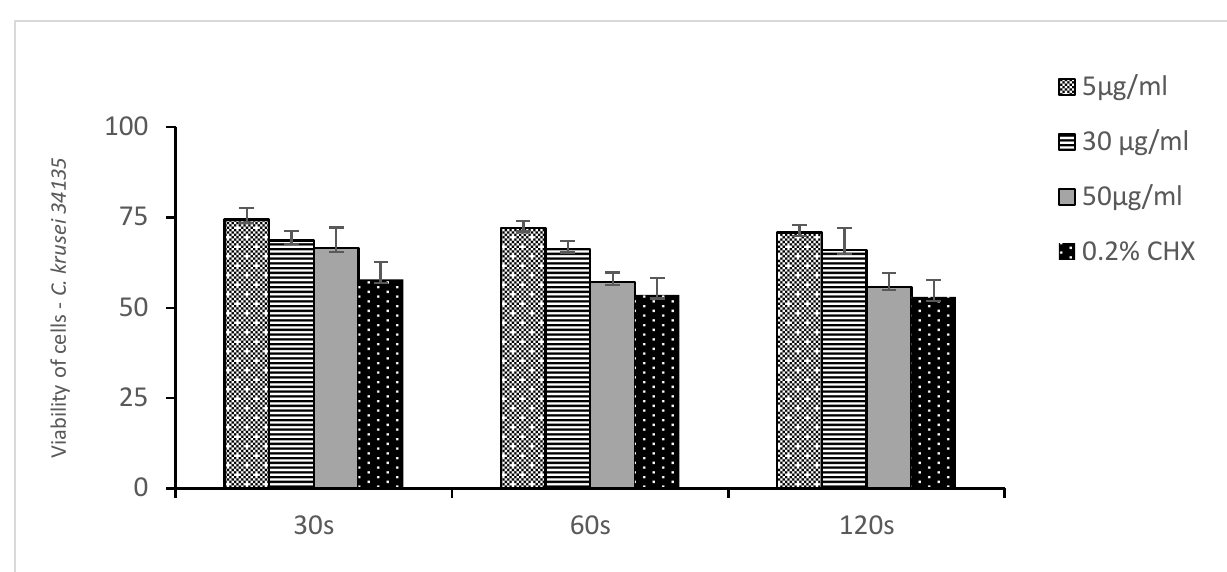
Figure 4. Viability of cells of Candida krusei ATCC 34,135 to ozonated water and chlorhexidine at three exposure times. n = 8.